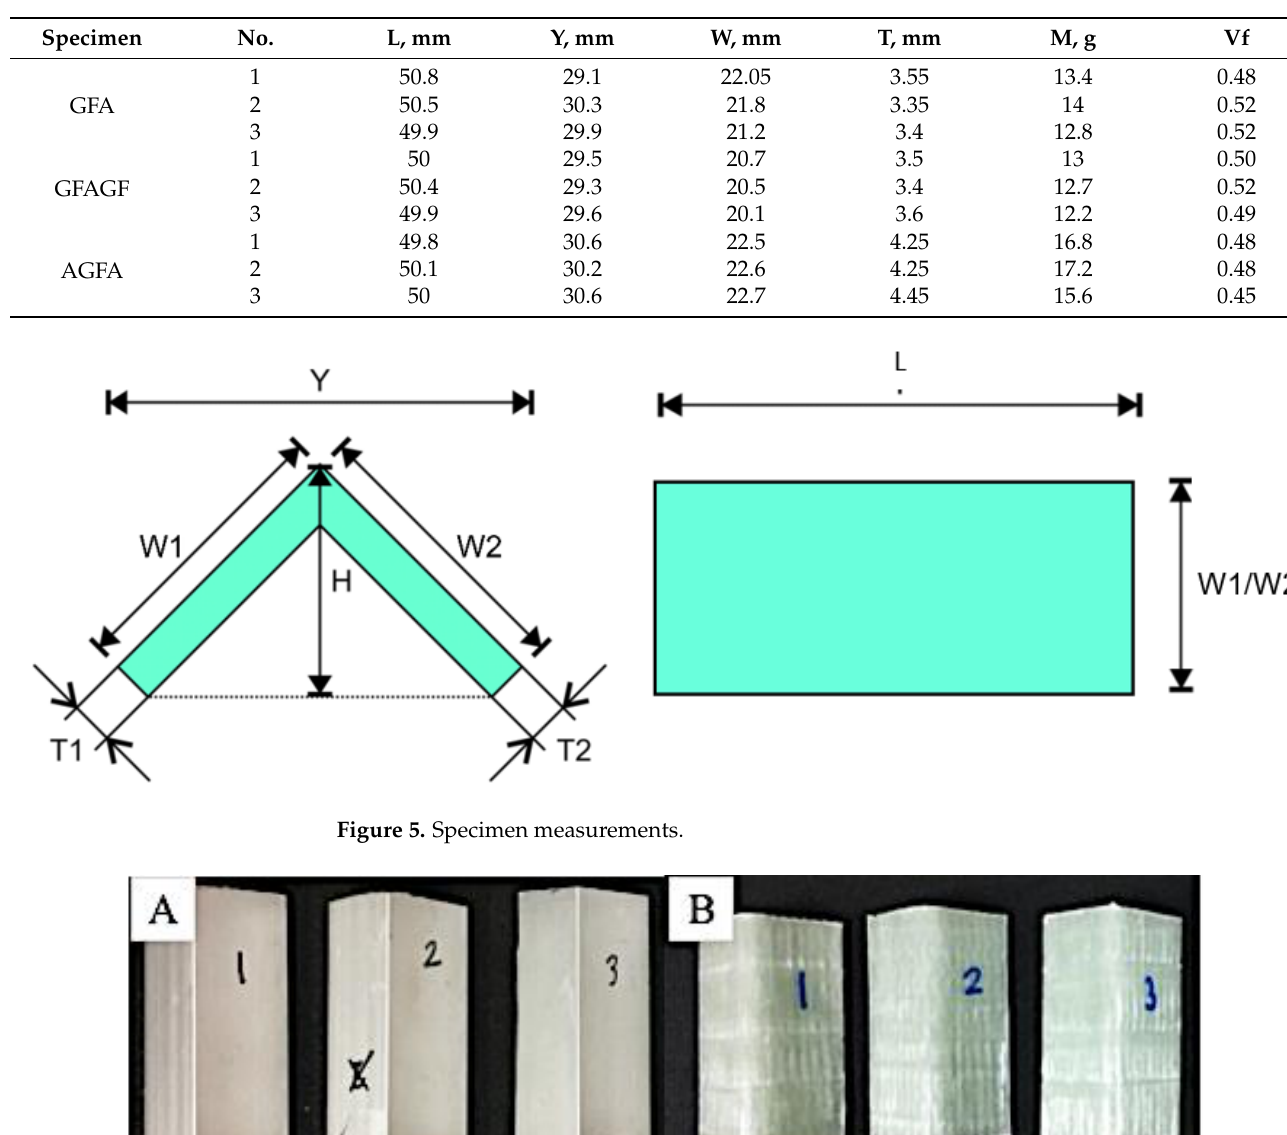
Table 2. Lateral compression specimen dimensions and volume fraction.